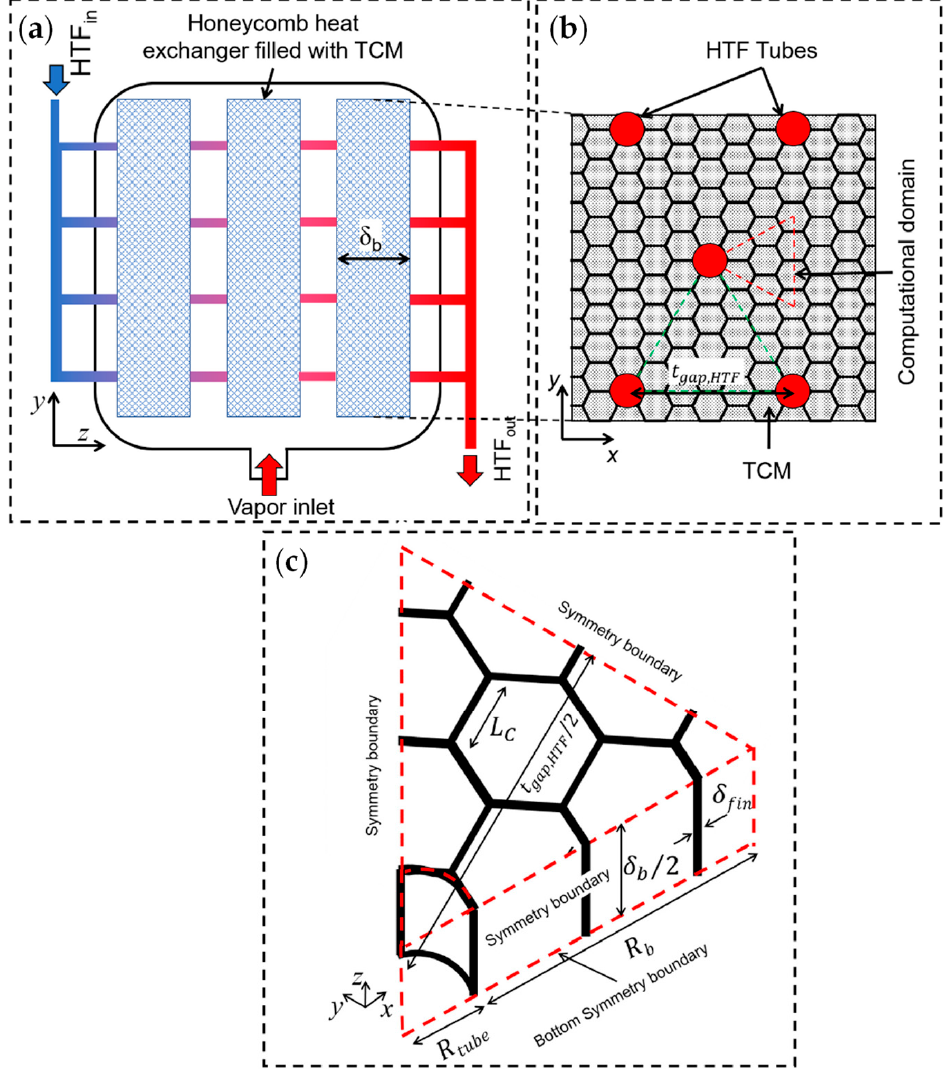
Figure 22. Schematic of the geometry of the bed: (a) TCM energy storage system, (b) side view of honeycomb heat exchanger filled with TCM, (c) computational domain [257]: Reprinted with permission from Ref. [257] Copyright © 2021 Elsevier Ltd. All rights reserved.